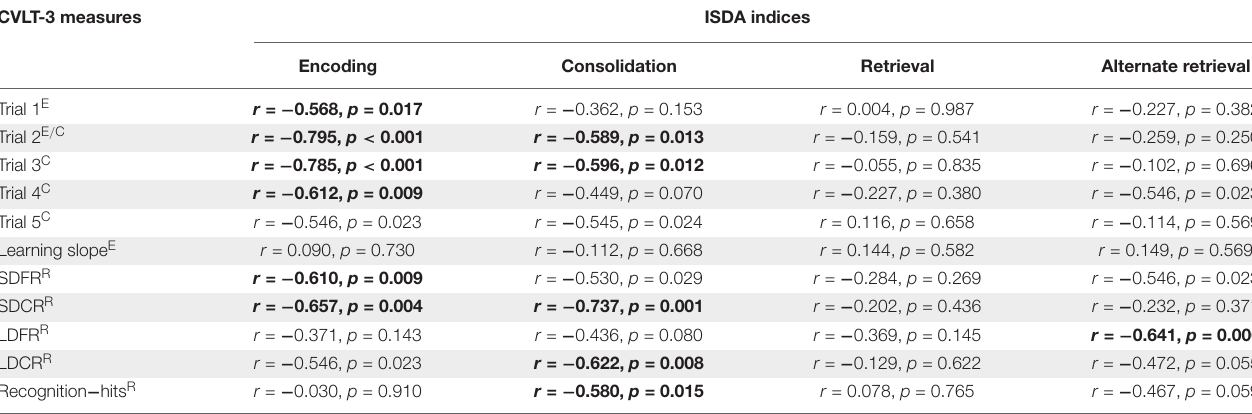
TABLE 6 | Pearson correlations between the CVLT-3 and